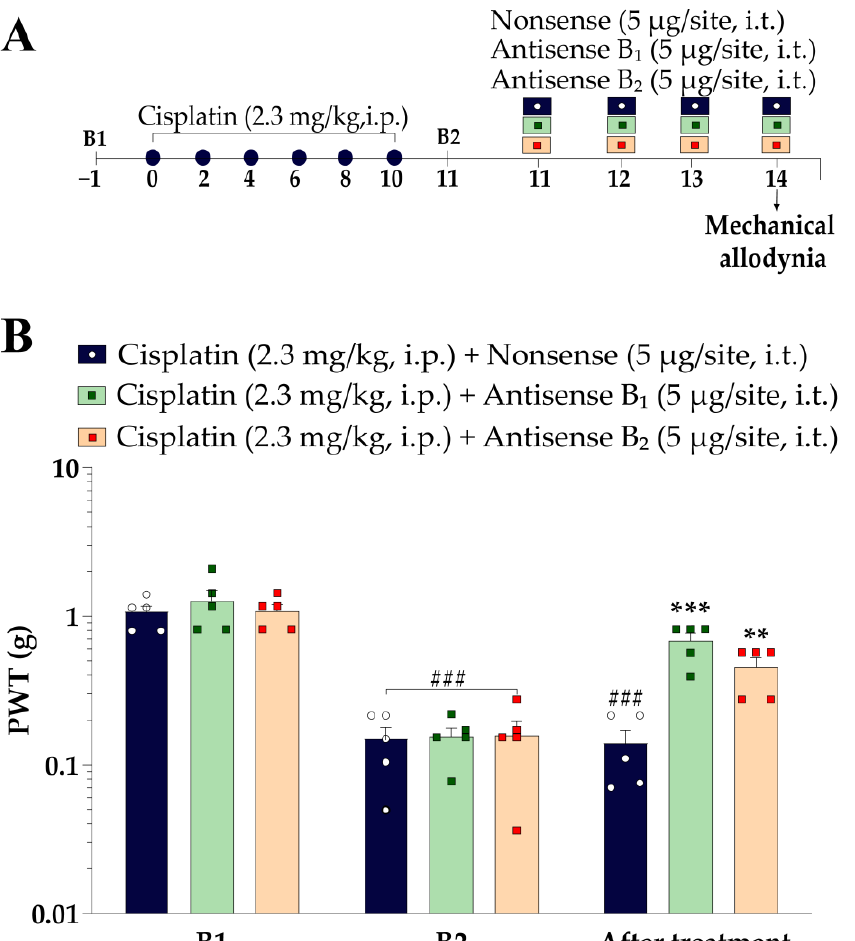
Figure 7. Antisense oligonucleotides for kinin B 1 and B 2 receptors relieved cisplatin-caused mechan- ical allodynia. ( A ) Male Swiss mice were treated by intraperitoneal (i.p.) injections with cisplatin (2.3 mg/kg) every 48 h for 10 days. Mice were treated with antisense oligonucleotides targeting kinin B 1 and B 2 receptors, and nonsense control was administered via the intrathecal (i.t.) route for three consecutive days every 12 h and 1 h before assessment of mechanical allodynia on the 14th day after induction of peripheral neuropathy by cisplatin. ( B ) Mechanical allodynia was evaluated on the 14th day after cisplatin-induced peripheral neuropathy. B1 values were measured before the first cisplatin dose. B2 values were measured on the 11th day after the first cisplatin dose and before the treatments. Results are presented as mean + SEM (n = 5 – 6/group). The symbols on the bars indicate individual values for each animal. ### p < 0.001 compared to baseline threshold (B1). ** p < 0.01; *** p < 0.001 compared to the nonsense group. Two-way ANOVA repeated measures followed by Bonfer- roni ’ s post hoc test. PWT: paw withdrawal threshold.